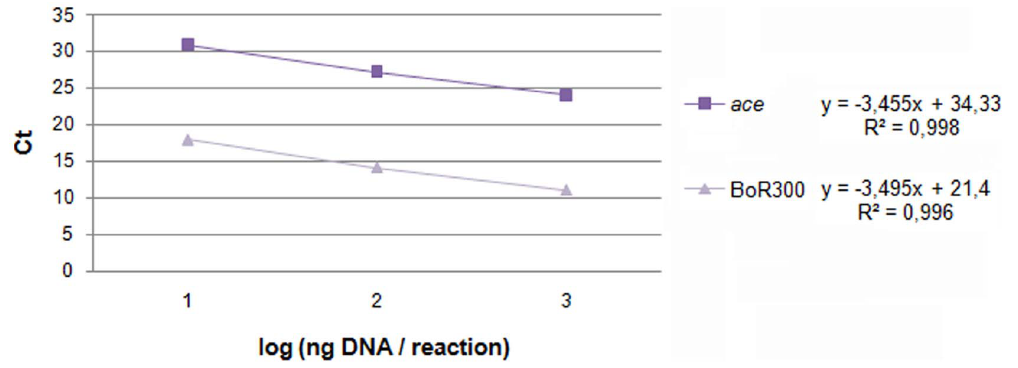
Figure 7. Standard curves for the reference single copy gene ( ace ) and the repeats of BoR300. The construction of the curves was based on serial 10-fold dilutions of the genomic DNA template used (10 pg, 100 pg, 1 ng). For each amplicon, qPCR determined Ct values were plotted against the logarithm of their initial concentration (1, 2 and 3 values respectively).